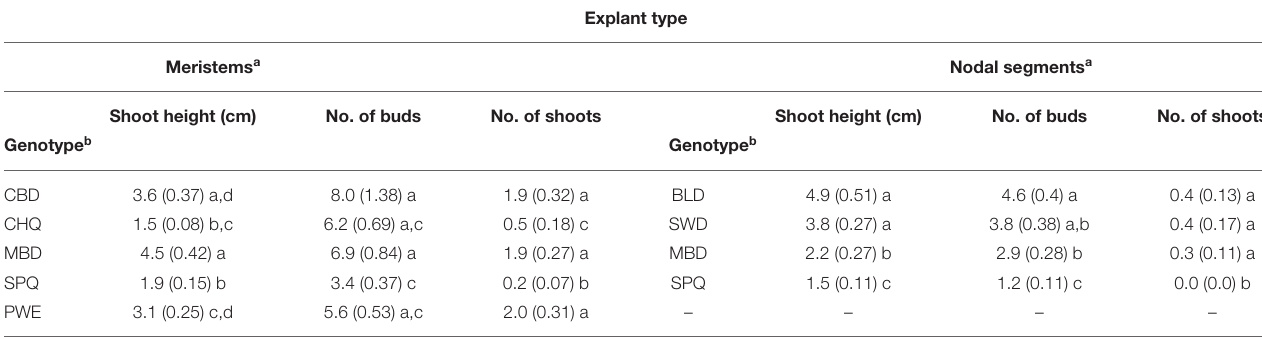
TABLE 1 | Comparison of growth of shoots from meristems and nodal explants of five genotypes of drug-type Cannabis sativa